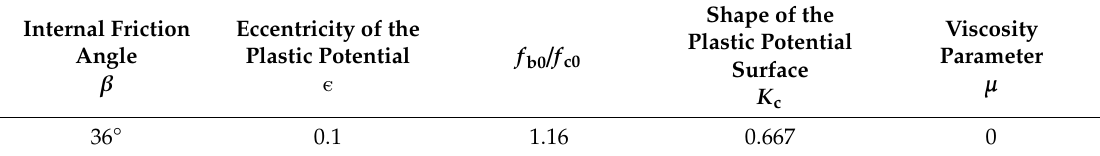
Table 2. Parameters of the Concrete Damage Plasticity